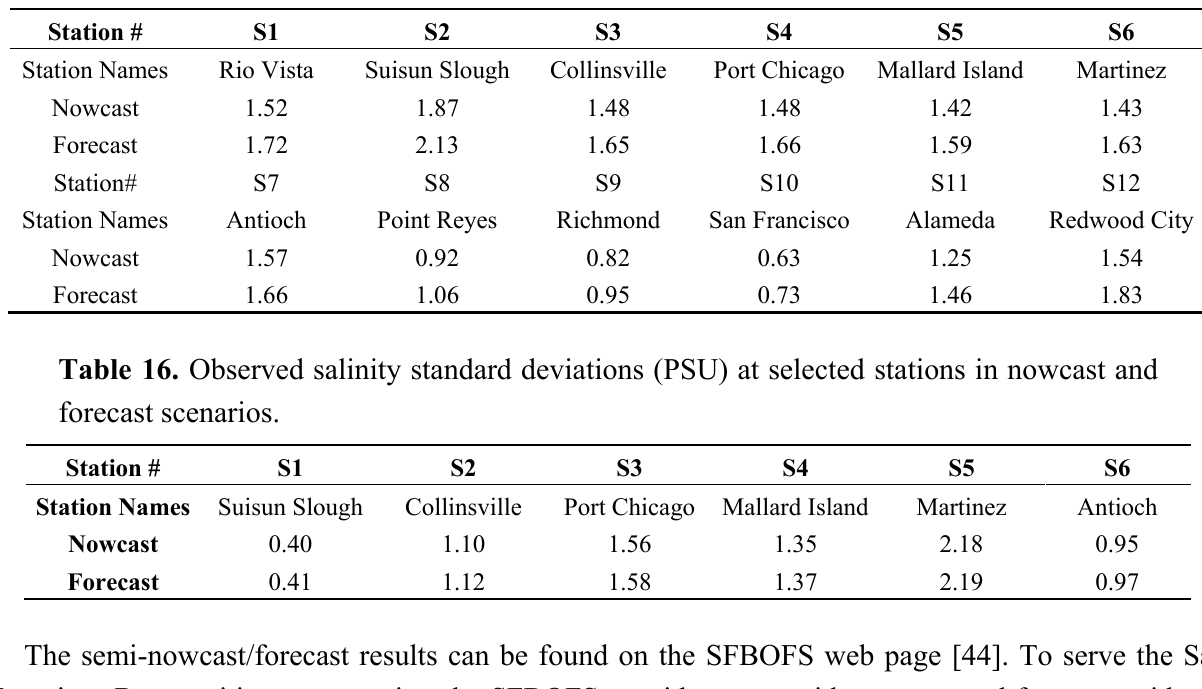
Table 15. Observed temperature standard deviations (°C) at selected stations in nowcast and forecast scenarios.